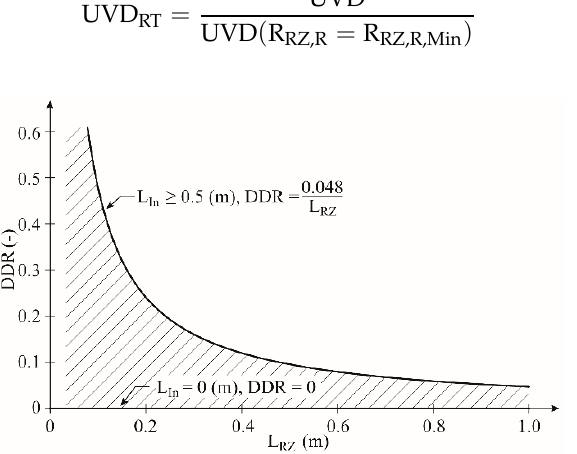
ffi cacies of the inflow and radiation Figure 8. Comparison of the efficacies of the inflow and radiation zones. Figure 8. Comparison of the e